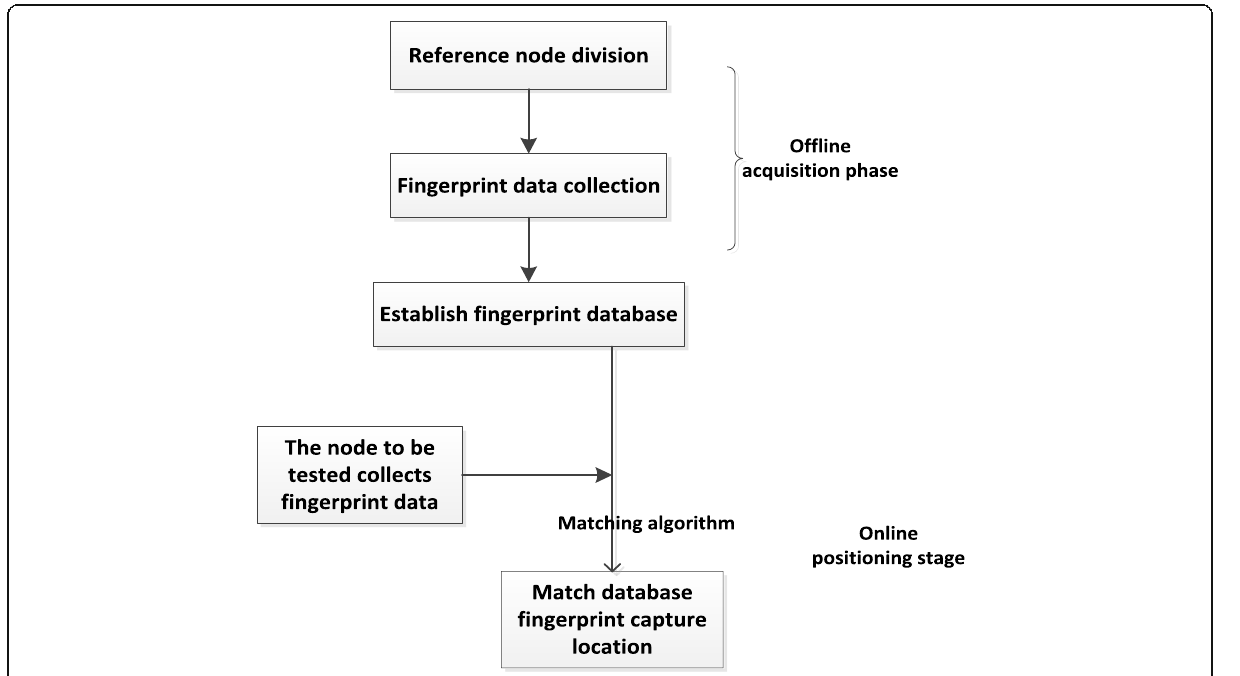
Fig. 2 The overall process of position fingerprint algorithm